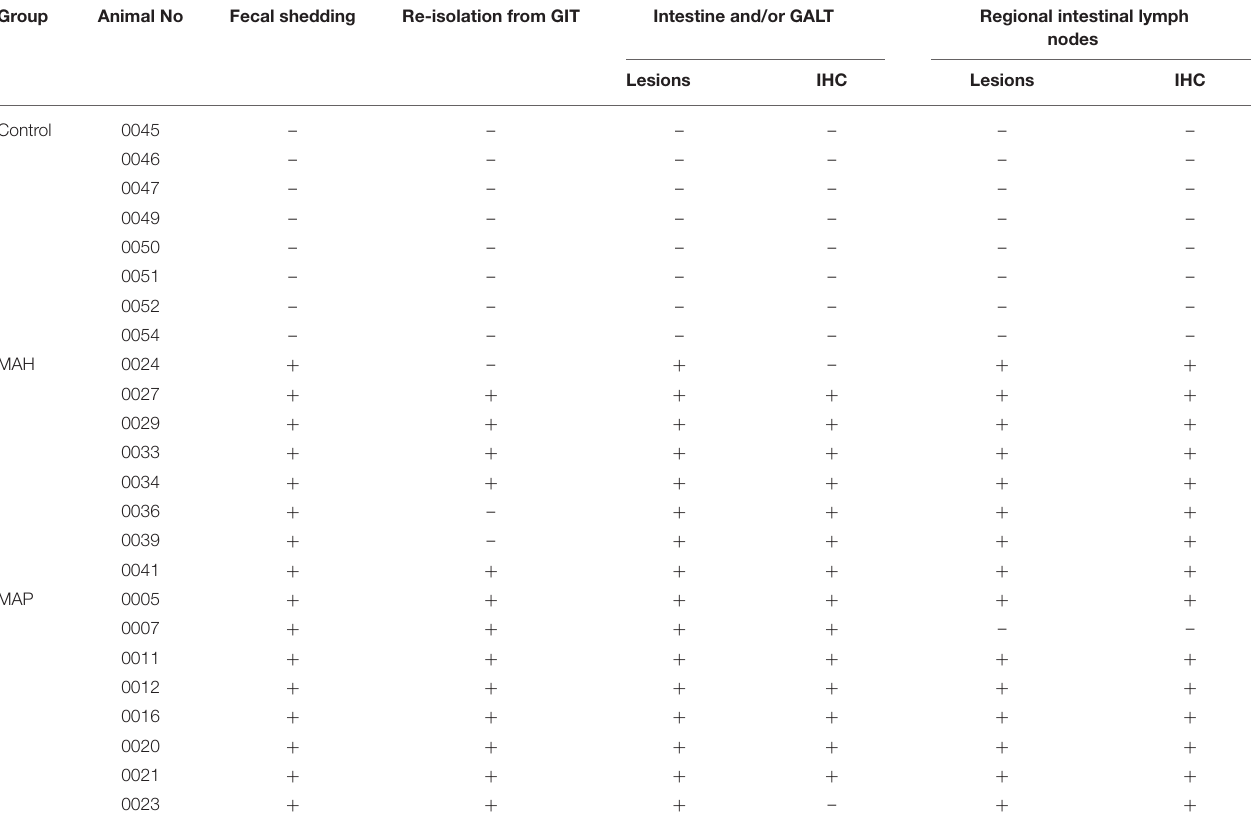
TABLE 2 | Results of fecal and tissue culture of MAP/MAH, presence of lesions and detection of mycobacteria by IHC. Group Animal No